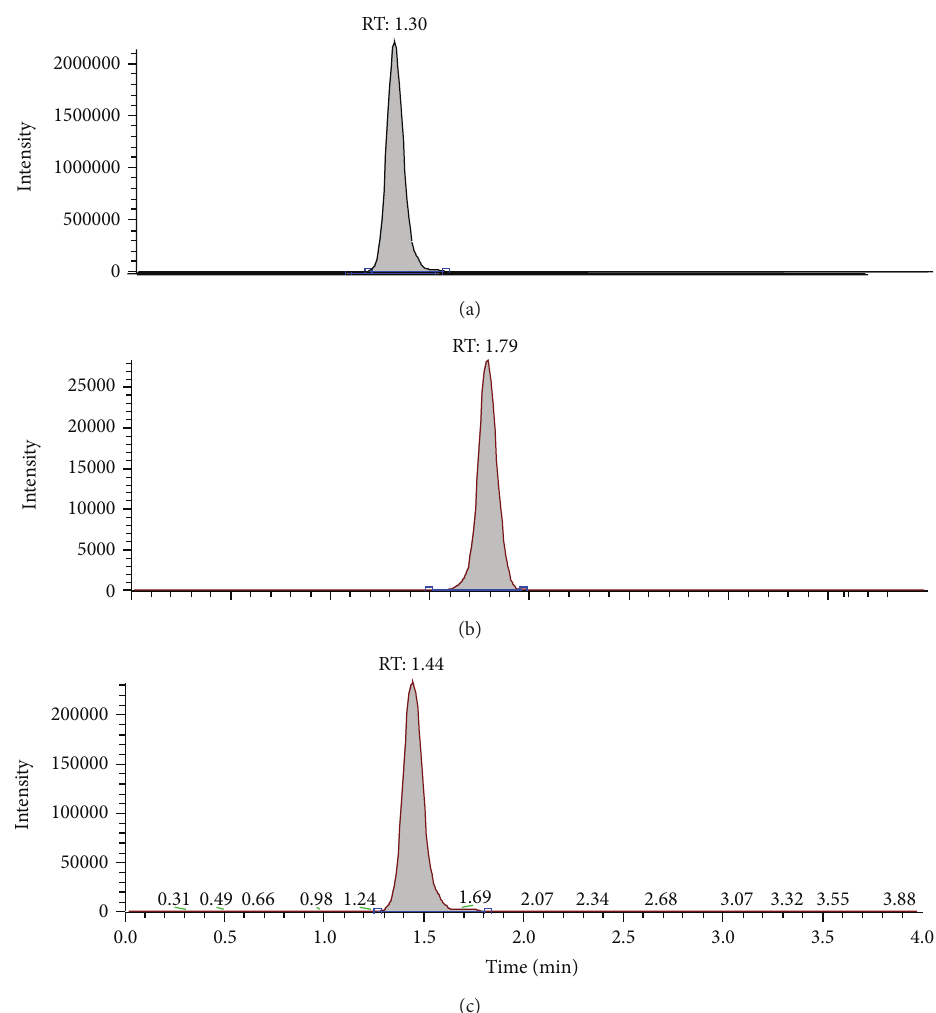
Figure 4: Representative chromatograms of plasma sample 60 min after intravenous administration of 25 mg/kg of PD-3% ((a) PD, (b) PD3, and (c) IS).